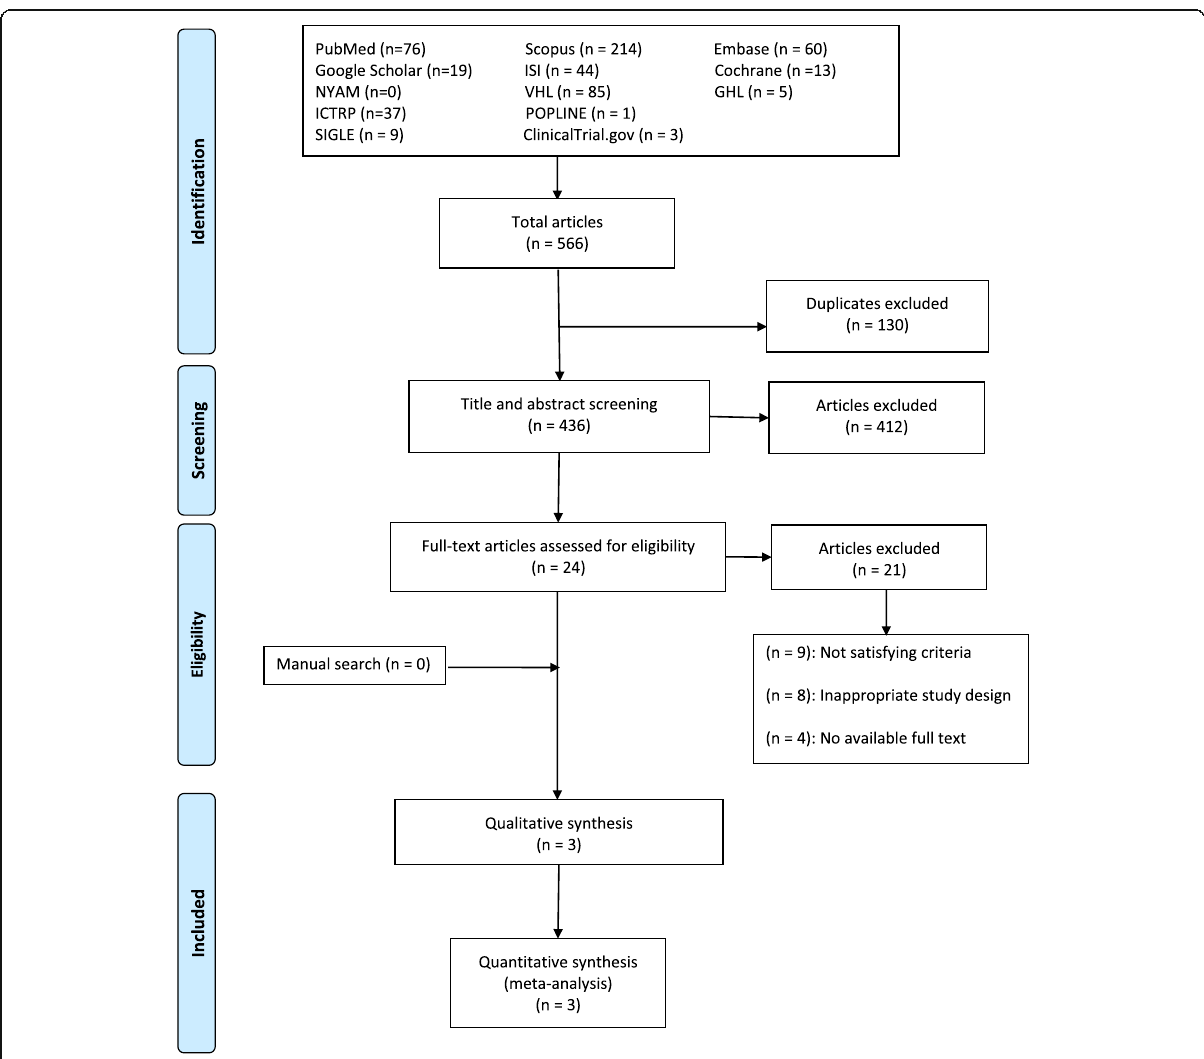
Fig. 1 PRISMA flow diagram of studies ’ screening and